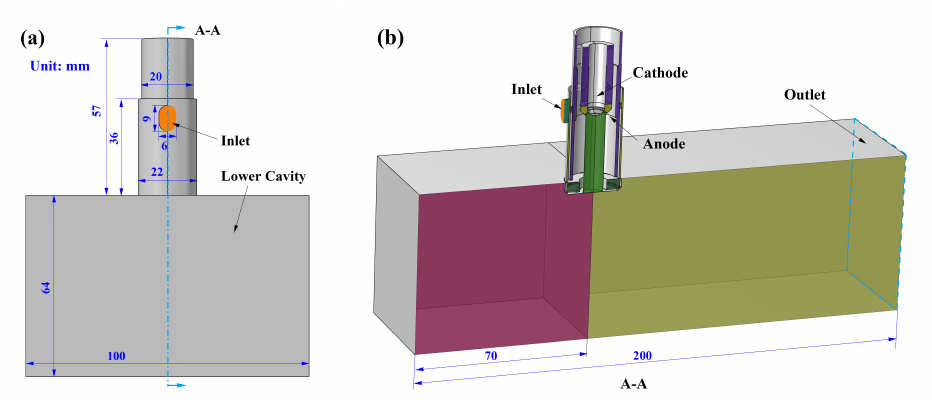
Figure 3. Computational domain of the 3D gas dynamics model. The inlet, outlet, cathode and anode are indicated. ( a ) The front view and ( b ) the section